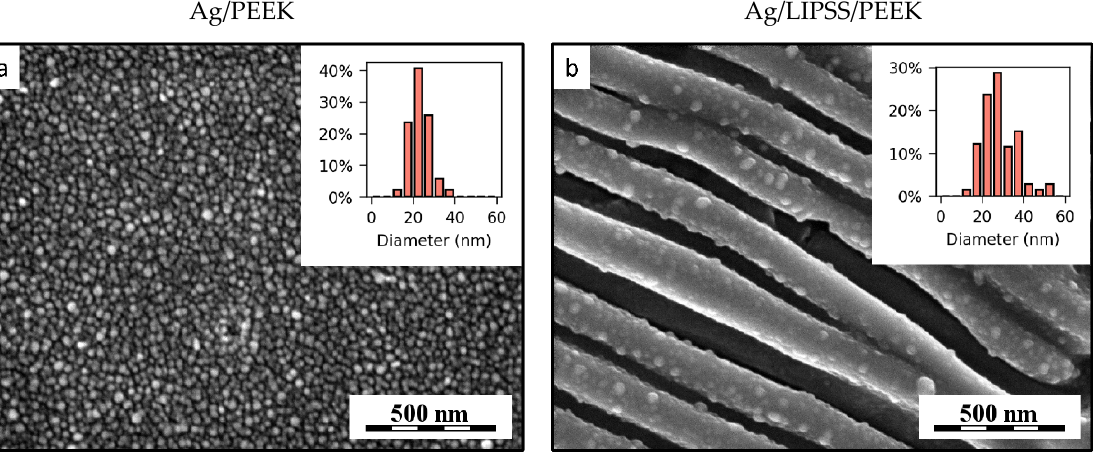
Figure 3. FEG-SEM micrographs of PEEK after immobilization with AgNPs ( a ) on as-received planar polymer (Ag/PEEK) and ( b ) on laser pre-treated polymer with LIPSS structure (Ag/LIPSS/PEEK). The insets in the upper right corner of both figures are histograms showing particle size distribution.